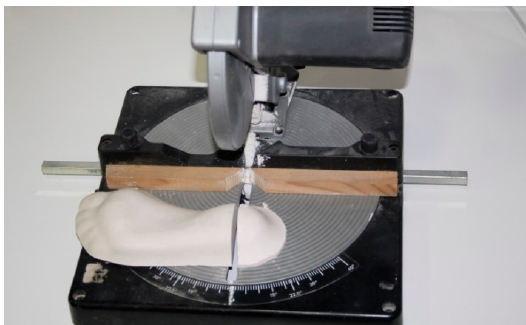
Figure 4. Cut of the cast in the zone of the heel. The piece of the heel cut was colored to better visualize the curvature, using a distinct colour for each procedure to enhance distinguishing which group each one corresponds to. Next, the frontal side of the piece was scanned on a scale (1:1). The outline of the curvature of the cut of the cast was visualized. We translated this to the AutoCAD ® 2009